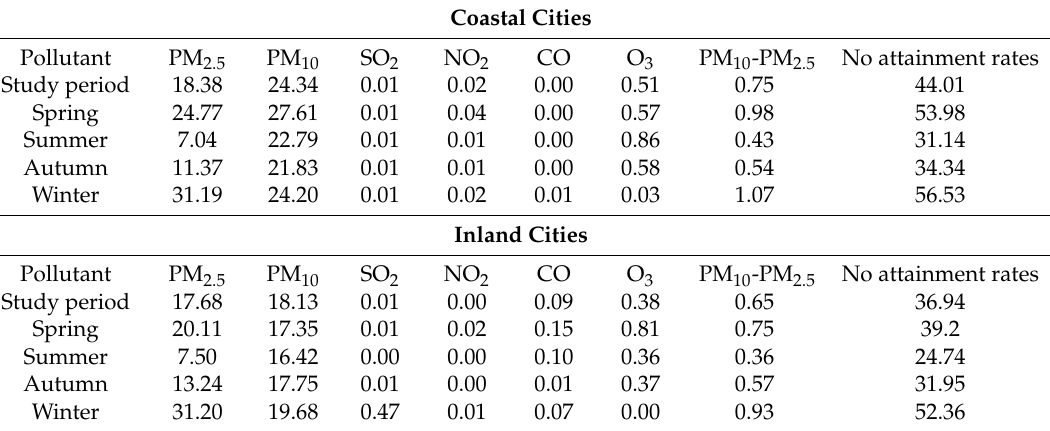
Table 4. The contributions of different air pollutants to the major pollutants (%) during the study period and the four